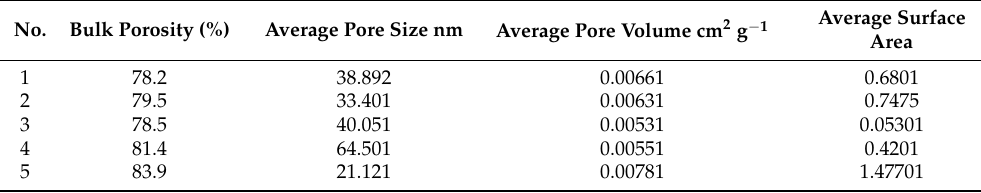
Table 4. The textural parameters measuring pumice rock samples (surface area, pore volume, po- rosity, and pore size).